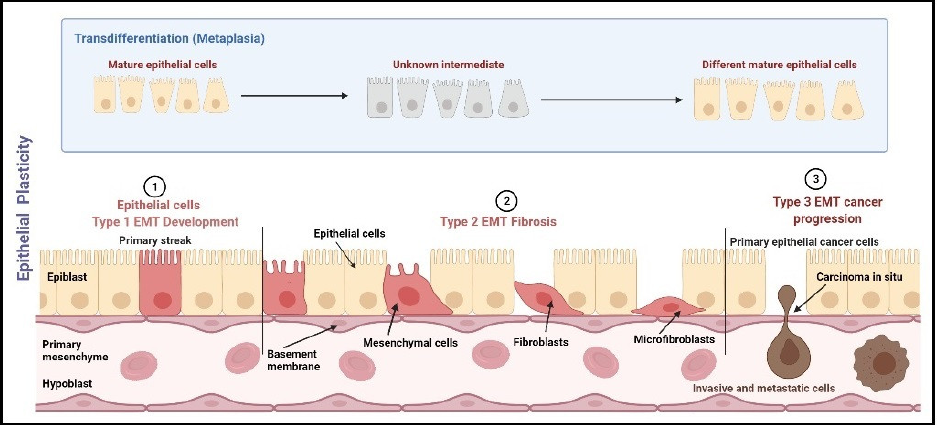
Figure 1. EMT categorization based on epithelial plasticity. EMT is categorized into three